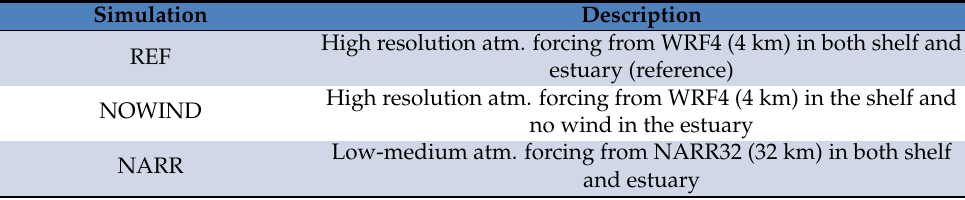
Table 1. Summary of the numerical simulations of 2014 used in this study. Simulation Description High resolution atm. forcing from WRF4 (4 km) in both shelf and REF estuary (reference) High resolution atm. forcing from WRF4 (4 km) in the shelf and NOWIND no wind in the estuary Low-medium atm. forcing from NARR32 (32 km) in both shelf NARR and